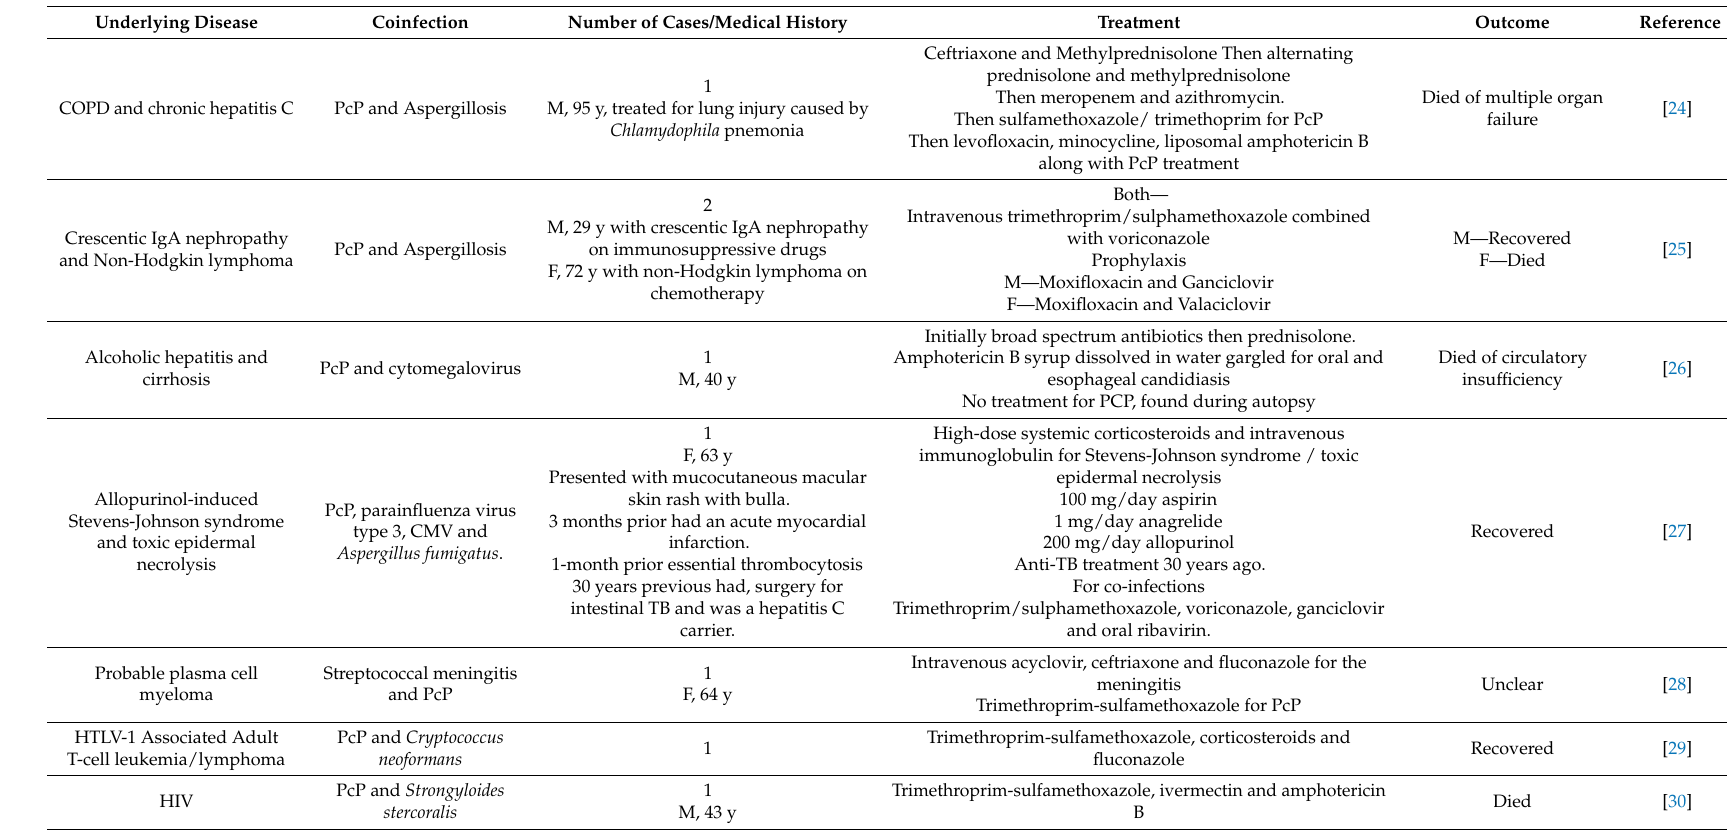
Table 3. A selection of Pneumocystis Pneumonia cases involving co-infection with other